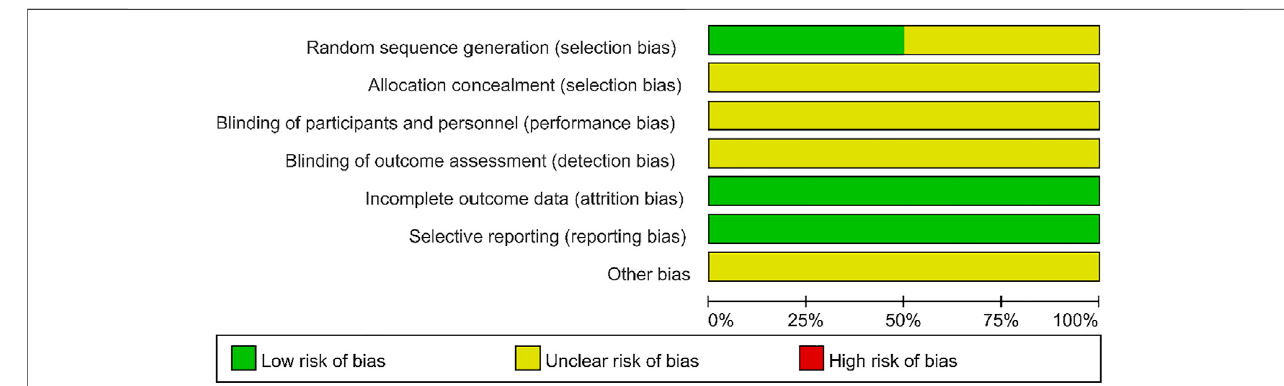
FIGURE 2 | Risk of bias